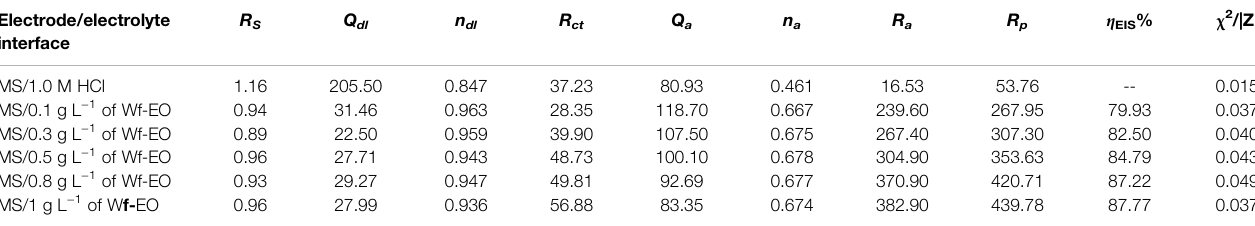
TABLE 3 | Inhibition ef fi ciency and EIS parameters for MS in 1.0 M HCl at different concentrations of Wf-EO. Electrode/electrolyte interface